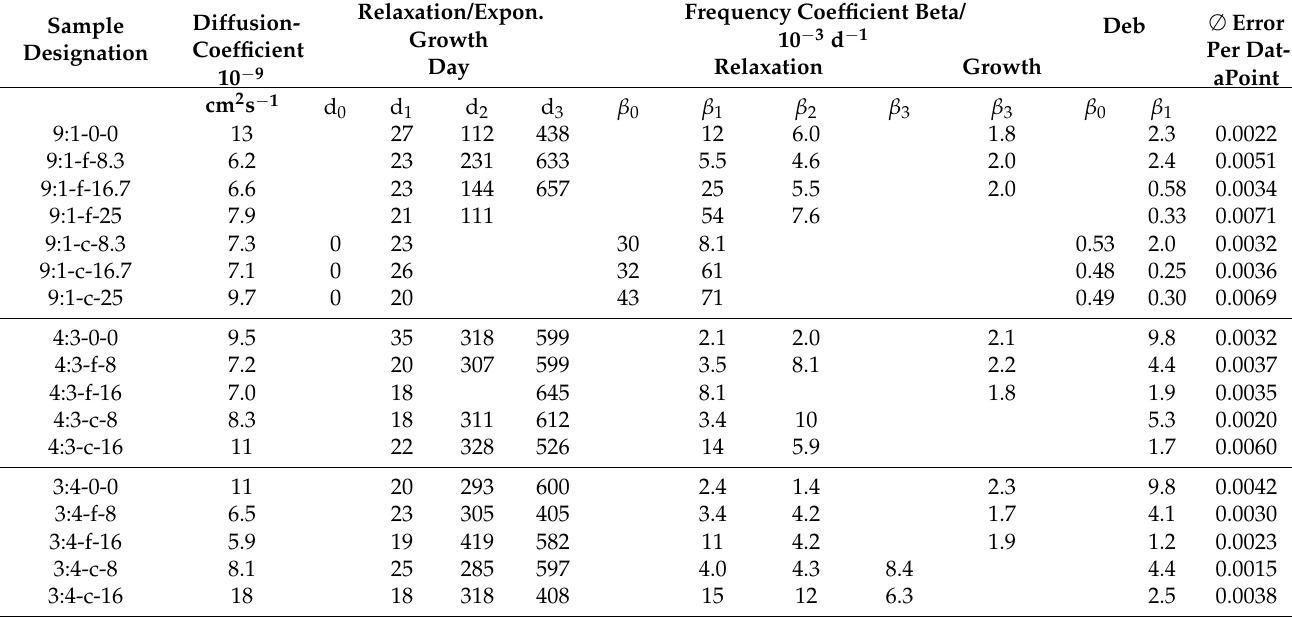
Table 3. Characteristic parameters of diffusion and relaxation phenomena from simulation of PLA–PBS–SBP composites.